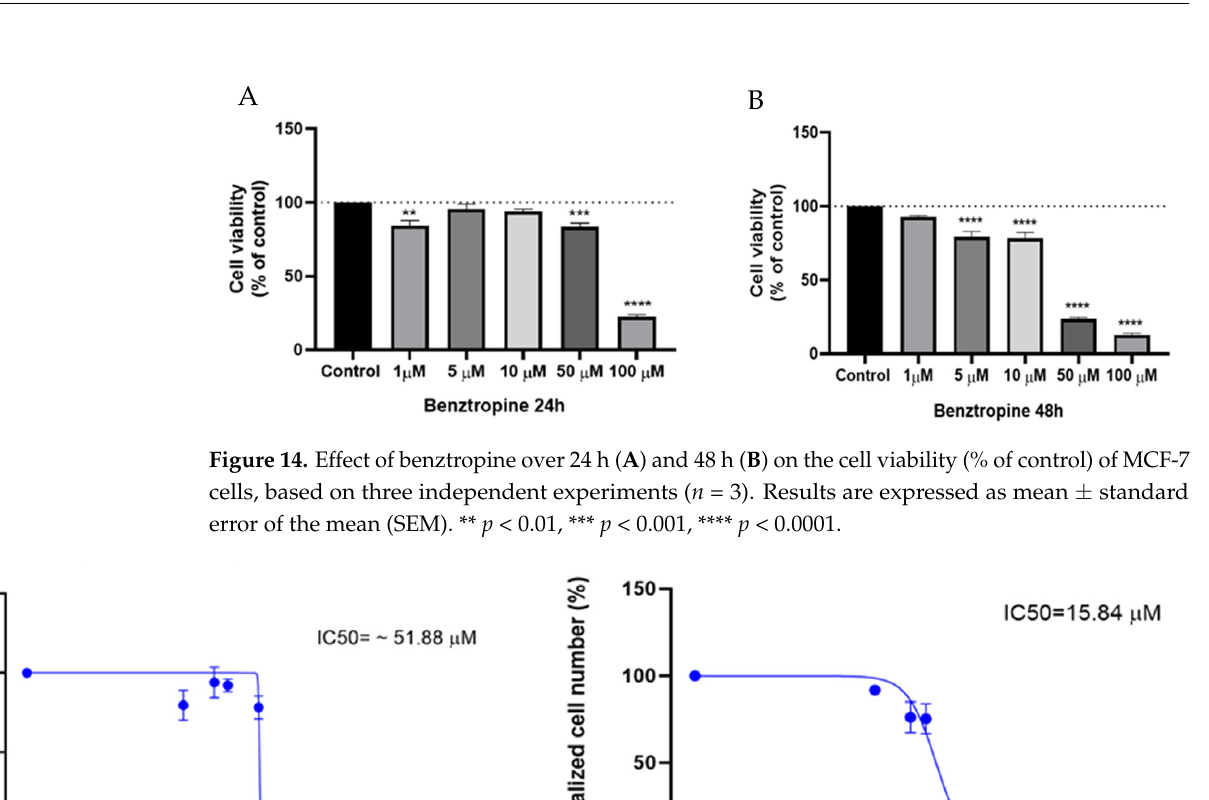
Figure 15. Representation of benztropine dose-response curve at 24 h (left graph) and 48 h (right graph). The curve represents a normalization between 0 and 100%, where 100% was defined as the concentration of the drug that least affected the cell viability, and 0% was considered the concentration that most affected the cell viability. Results are expressed as mean ± standard error of the mean (SEM). The IC50 value was calculated using the normalized data (between 0% and 100%). Comparison of the 24 h and 48 h exposures to benztropine (Figure 16) shows more effective prolonged exposure at 5, 10 ( p < 0.001) and 50 µM ( p < 0.0001); the cell viability is significantly lower at 48 h than at 24 h.